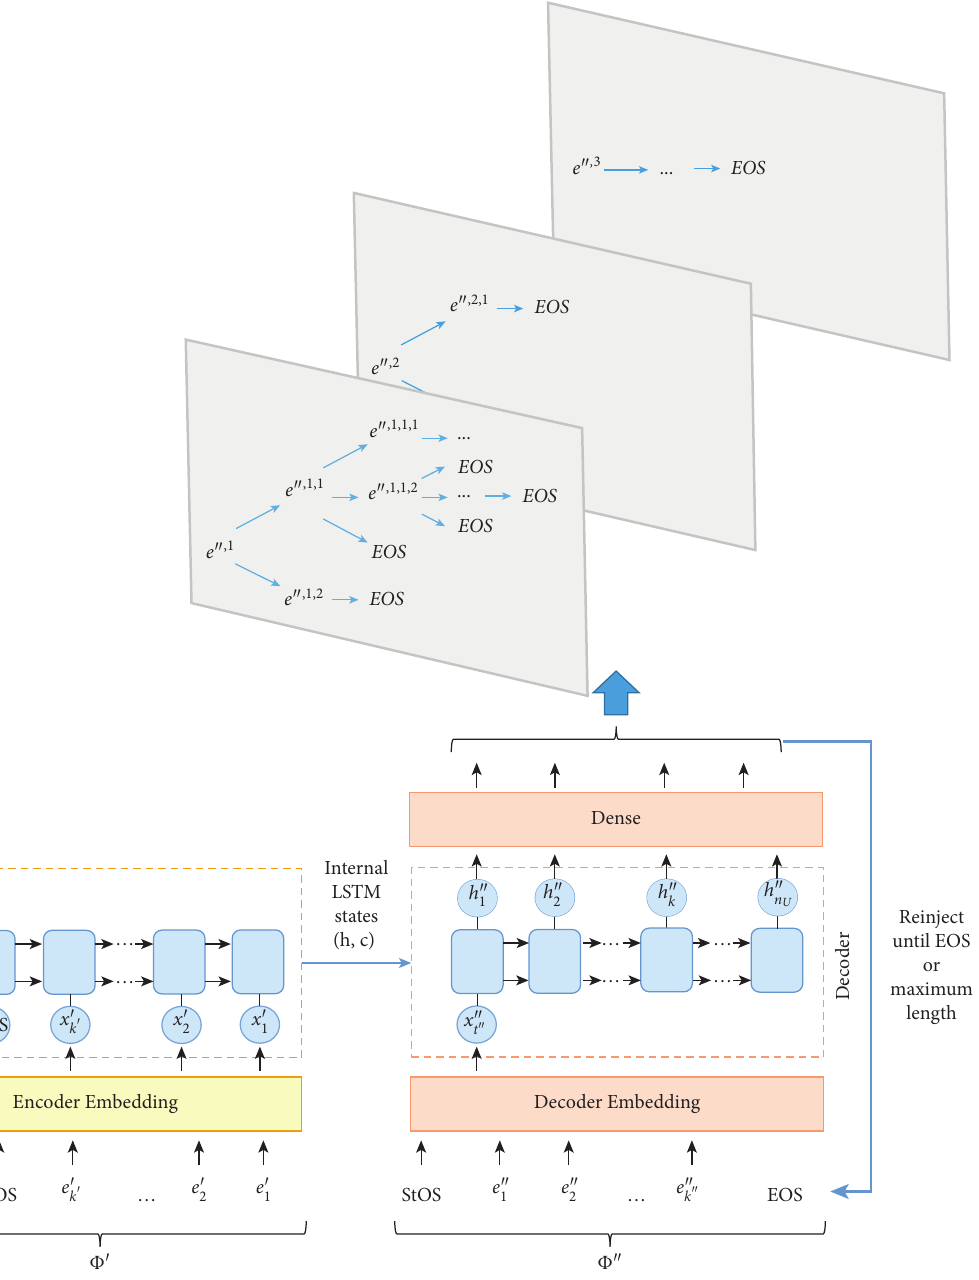
Figure 2: The illustration of the structure of the sequence-to-sequence event-scenario prediction. The encoder model maps the states of the input sequence into a fixed-length vector-based representation. Using these vector-based representations of input events as the initial state, the decoder model determines the next event. However, using the probabilities calculated by the dense layer, not just the event with the highest probability is recorded, but event scenarios are predicted using every prediction above a predefined threshold. The StOS and EOS tags mark the start-of-sequence and end-of-sequence tags,